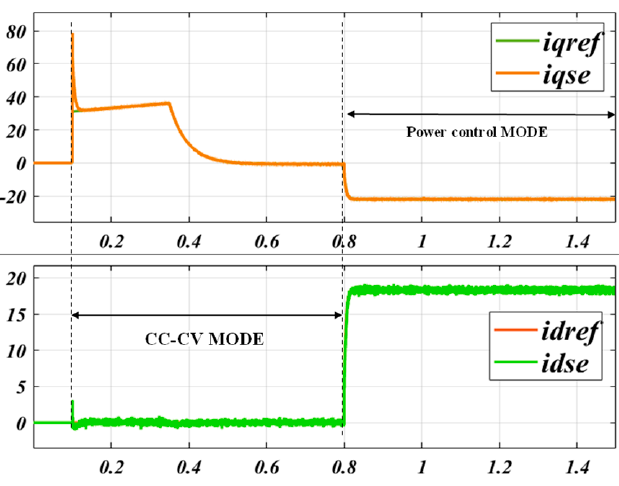
Figure 24. Simulation results of dq axis current.